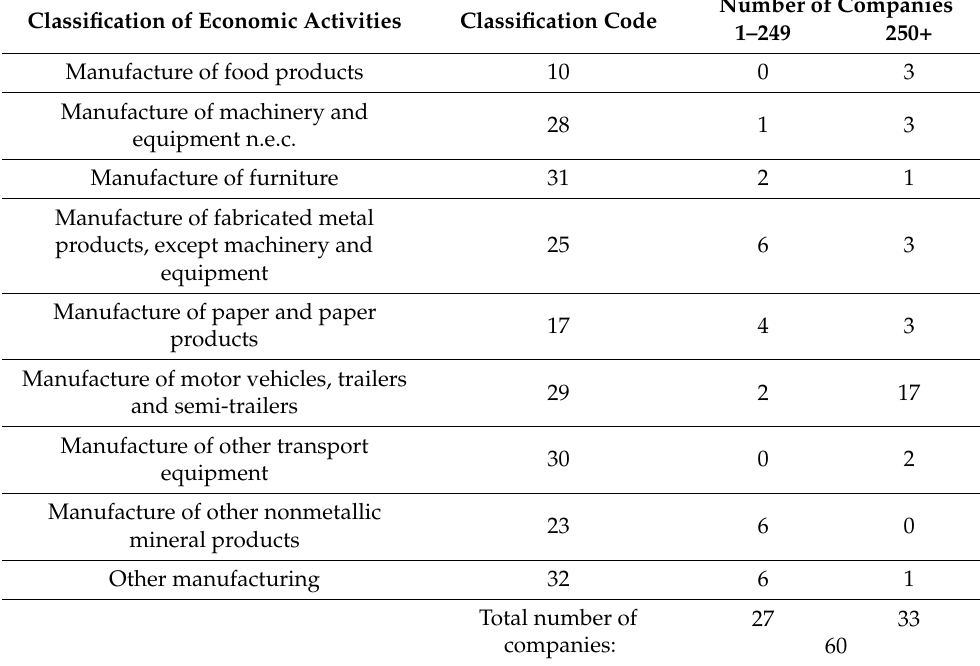
Table 1. Division of the surveyed companies by Statistical Classification of Economic Activities (NACE Rev. 2).